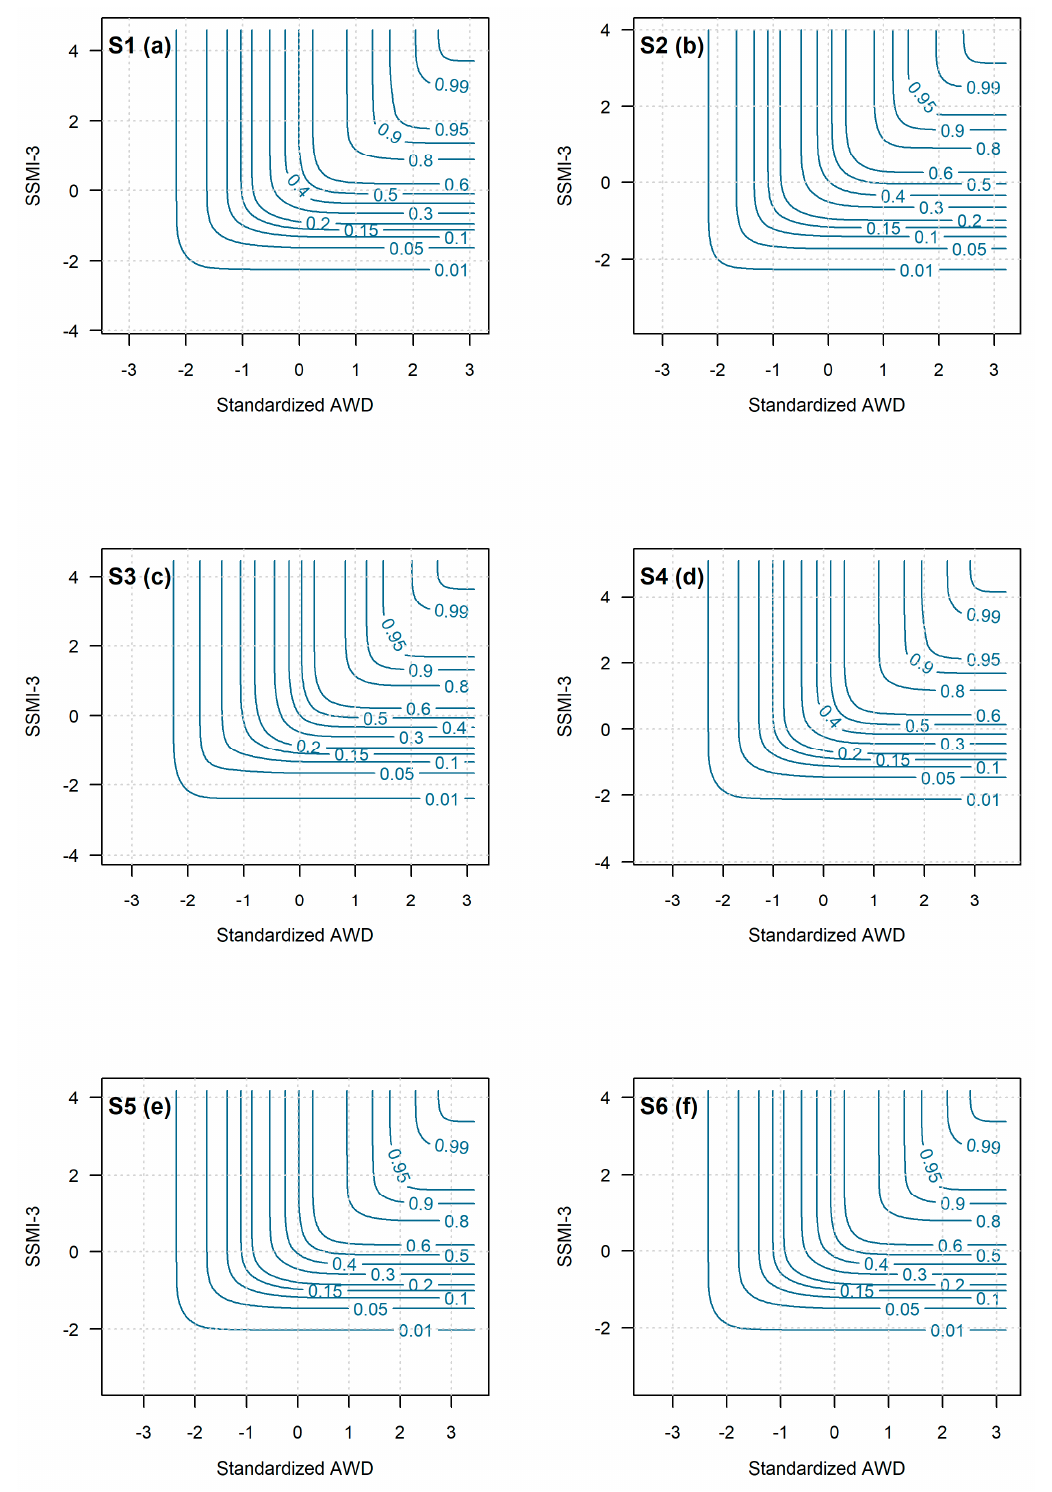
Figure 10. Bivariate distribution of SSMI3 and standardized AWD for summer at six representative stations ( a – f ).